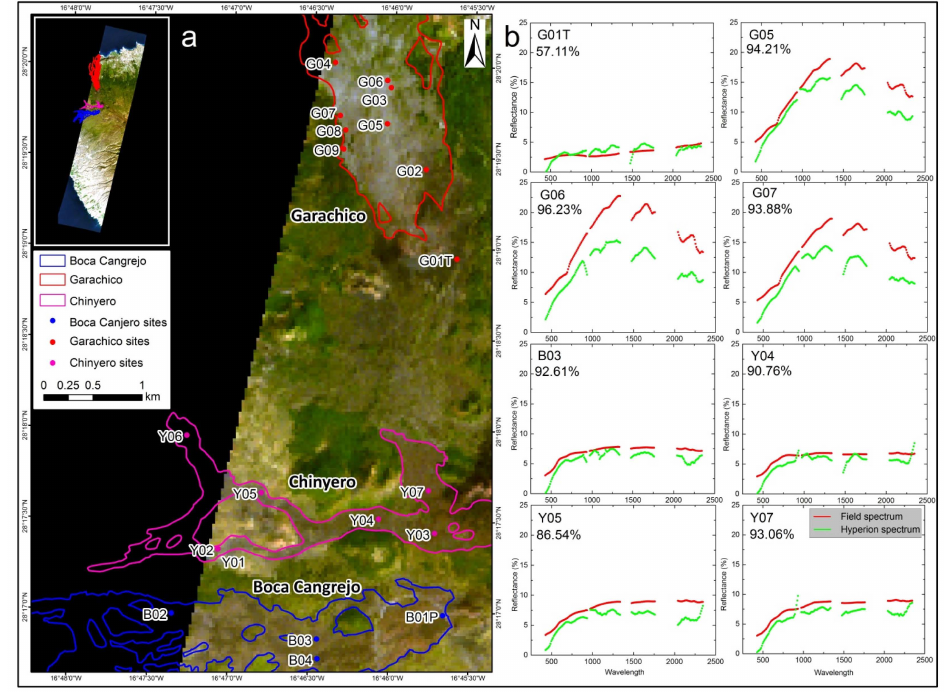
Figure 5. ( a ) Hyperion image of Tenerife acquired on 10 September 2003, showing the extent of lava flows and measured sites indicated by their names; ( b ) Graphs comparing field spectra resampled to the wavelength of the Hyperion sensor (red curves) and smoothed Hyperion spectra (green curves) for selected sites including one tephra site on the Garachico cone (G01T), three Garachico lava sites characterized by lichen cover (G05–G07), one Boca Cangrejo lava site (B03) and three Chinyero lava sites characterized mainly by intermediate level of surface oxidation (Y04, Y05 and Y07). The correlations between the two spectral curves are provided below the site